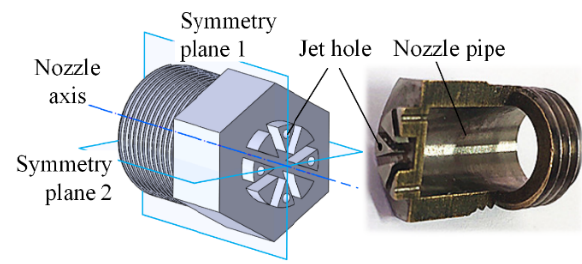
Figure 1. Nozzle structure.